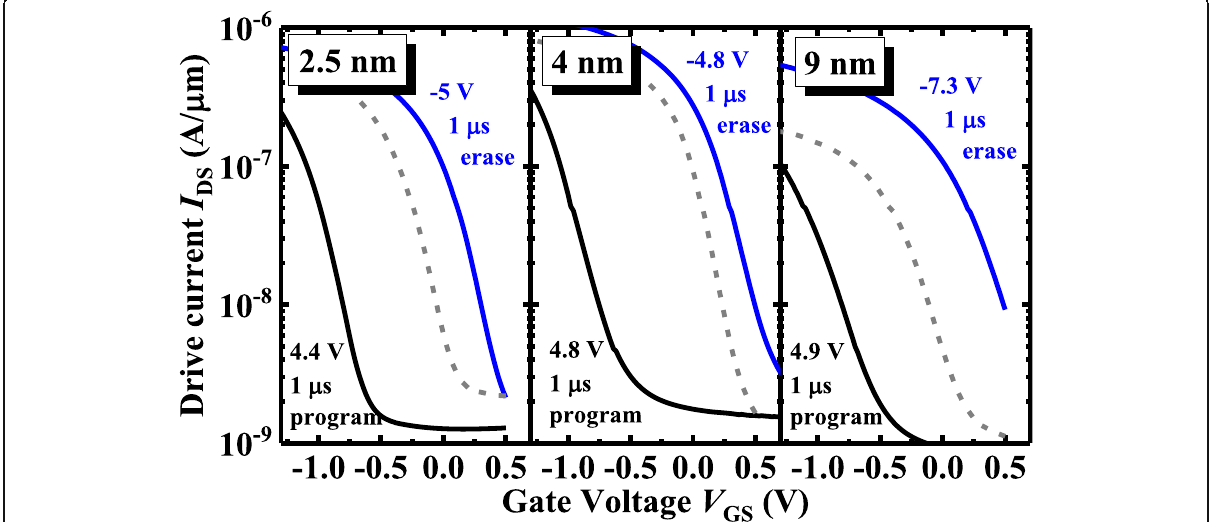
Fig. 6 Measured I DS - V GS curves of the 2.5, 4, and 9 nm-thick ZrO 2 FeFETs for the initial and two polarization states with 1 μ s P/E